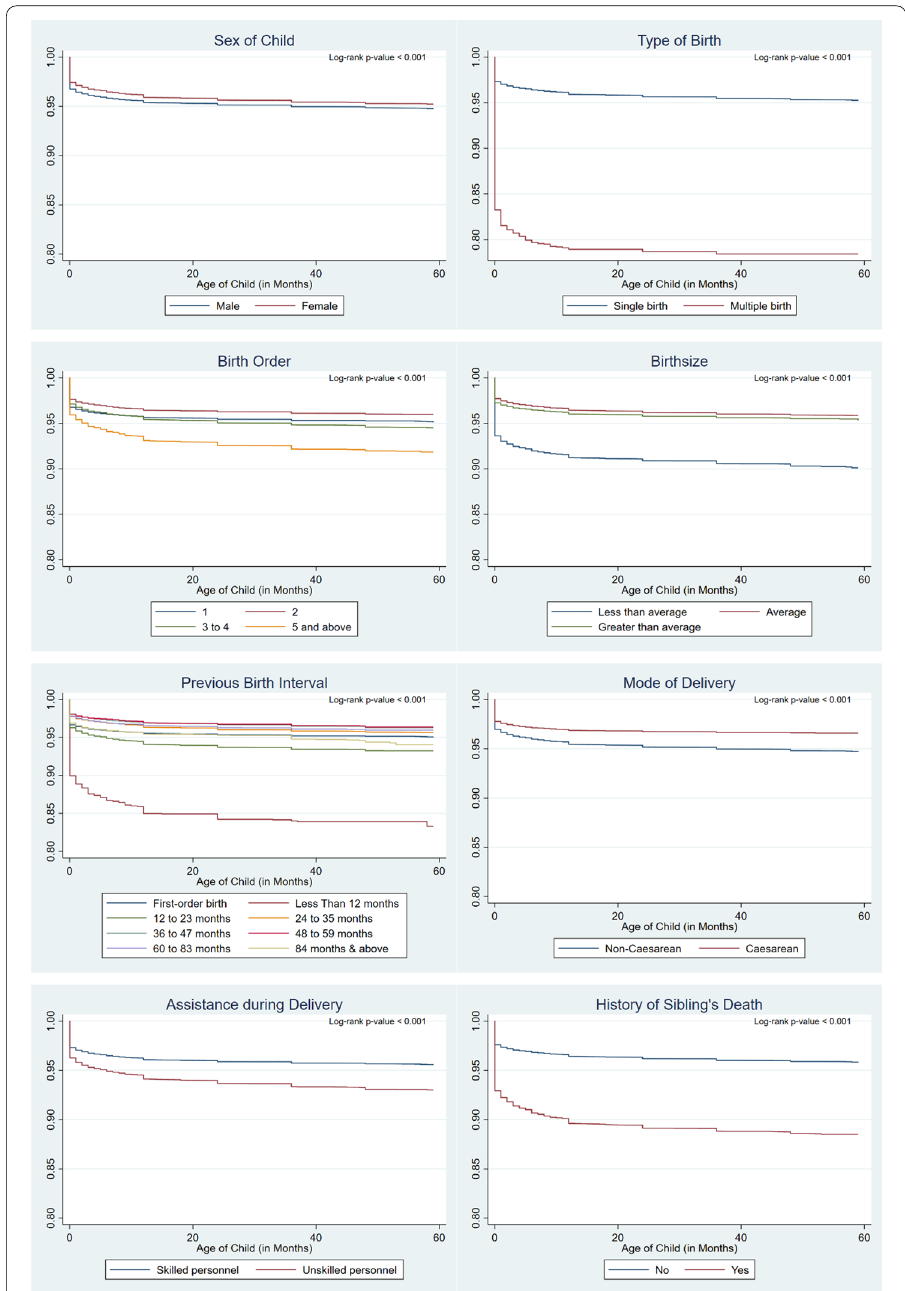
Fig. 2 Kaplan–Meier survival curve for under-five mortality in India by child characteristics with the p-values obtained from the log-rank